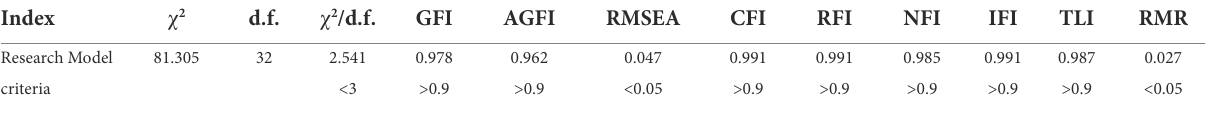
TABLE 3 Model fit indices.